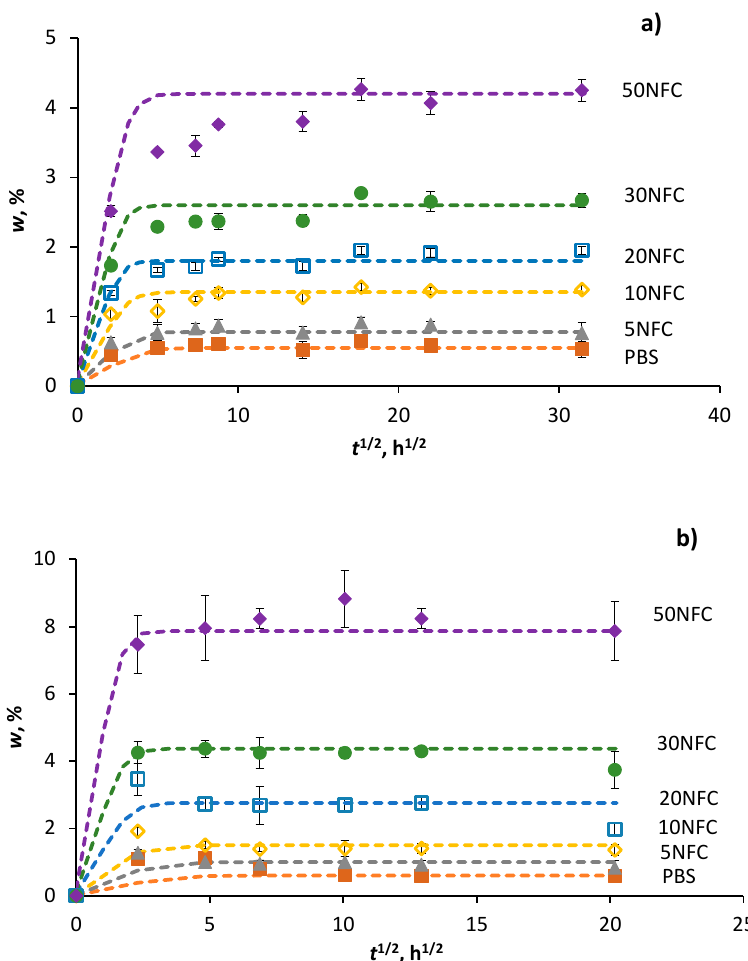
Figure 1. Weight gain of PBS/NFC composites conditioned under RH 98%, 22 °C ( a ) and in water at 50 °C ( b ). Lines are calculated by Equation (3).